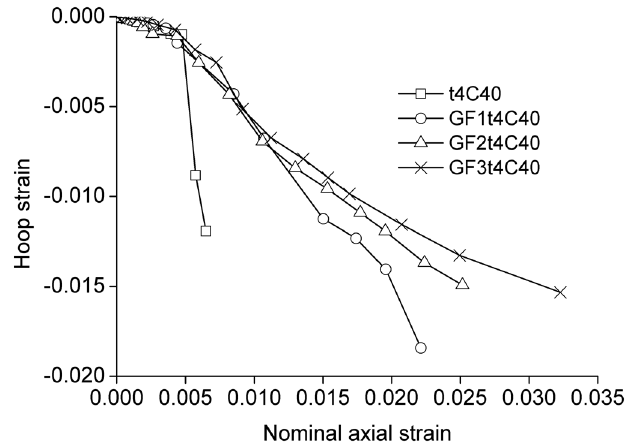
Figure 8. Nominal axial strain vs. hoop strain in terms of FRP layer